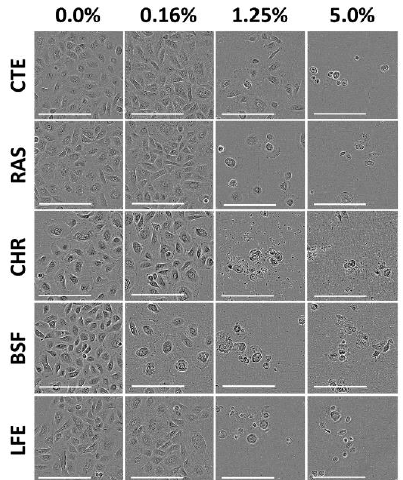
Figure 2. Cytotoxicity assessment of flavors in human primary gingival keratinocytes. Representative image of morphological changes in Keratinocytes (20×) after treatment with either chocolate natural and artificial (CTE), raspberry flavor artificial (RAS), cherry flavor (CHR), bitterness suppressor flavor (BSF) and lemon flavor extract (LFE). Concentrations of flavors used were 0.16%, 1.25%, and 5% v / v in cell culture media. Images were captured after 72 h of treatment. Scale bars: 200 µm.